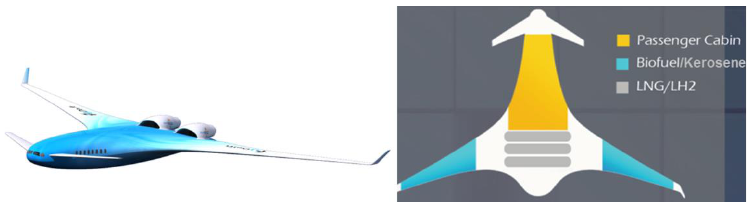
Figure 23. The multi-fuel blended-wing body investigated in the AHEAD project [37].